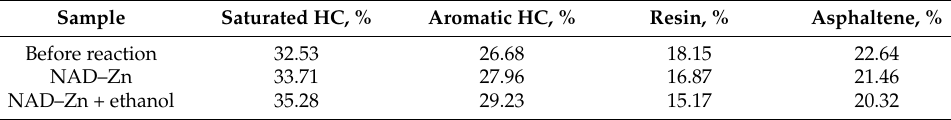
Table 1. Group compositions of oil sample before and after aquathermolysis.